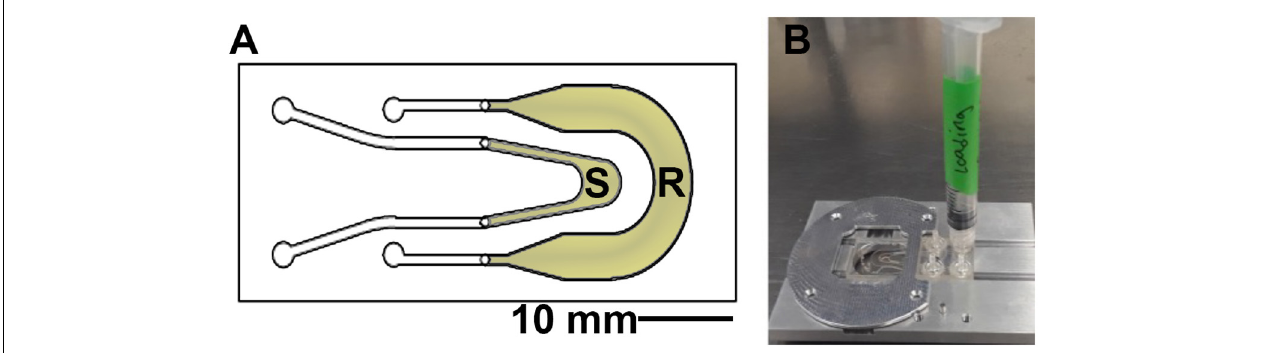
FIGURE 2 | Sample chamber arrangement. (A) Schematic of the 1 mm deep chamber, showing the sample (S) and reference (R) channels that permit the off-axis DHM geometry. The volume of view of each snapshot is 365 µ m × 365 µ m × 1 mm in x, y, and z. (B) The chambers were loaded using a 1 mL syringe and placed onto the microscope stage at a fixed focus before